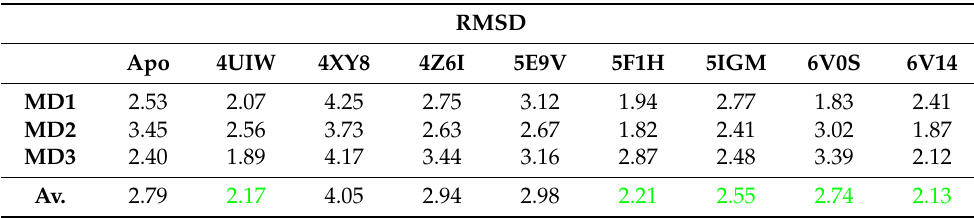
Table 2. Mean RMSD value of each system during the three simulations and the total average RMSD value. Average values lower than the apo form of the protein are highlighted in green. RMSD Apo